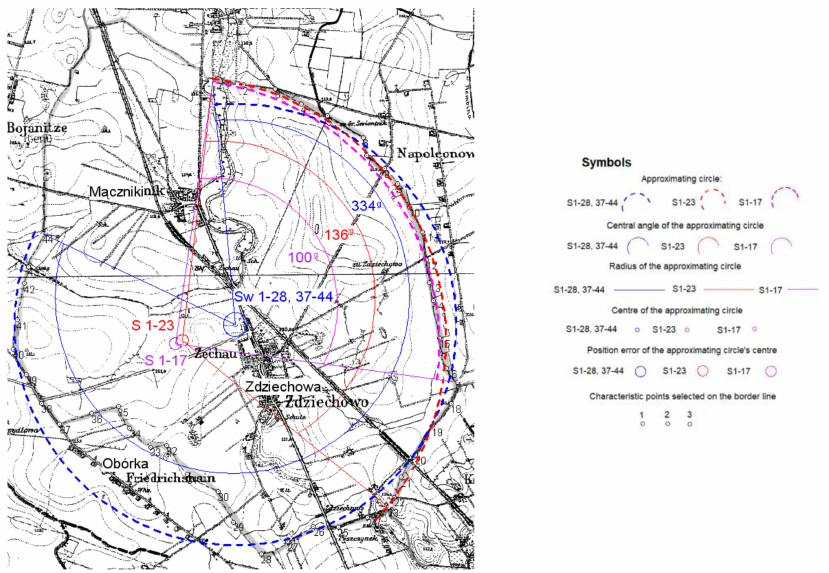
Figure 4. Wilkowyja. The course, position and error of the approximating circle’s center: Sw